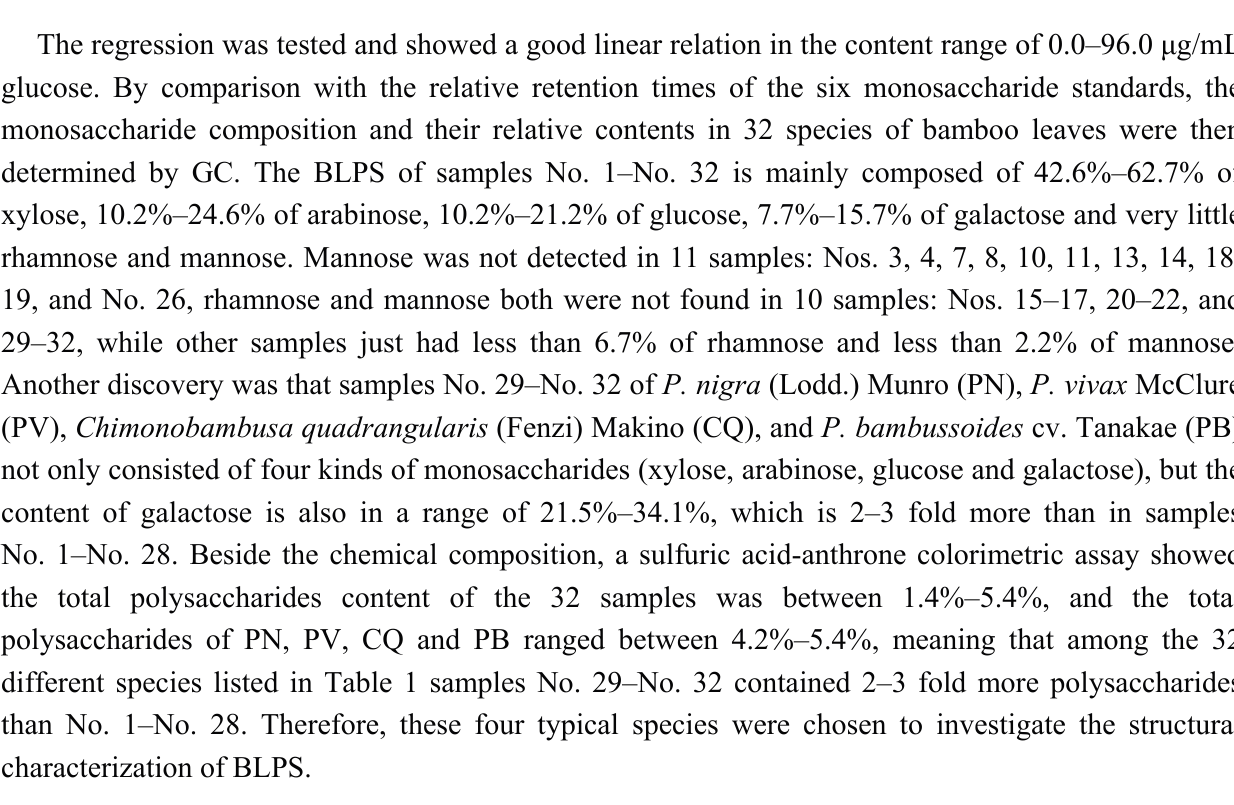
Table 1. The content of total polysaccharides and monosaccharides from 32 different varieties of bamboo